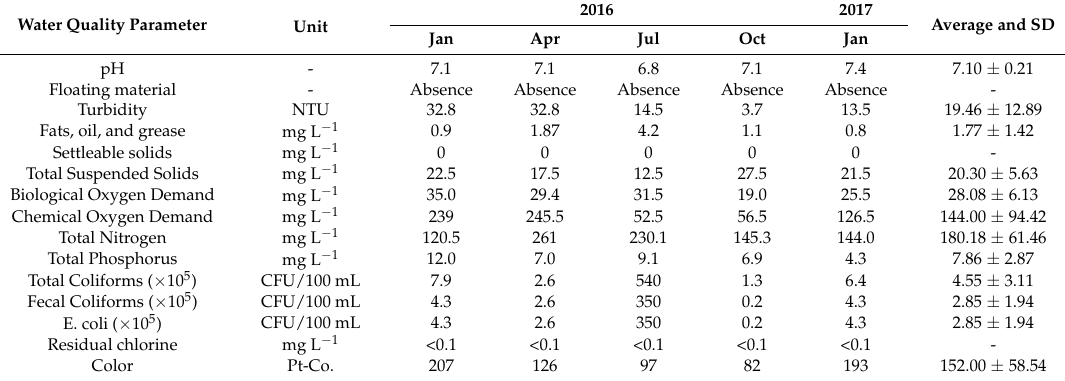
Table 4. Water quality parameters at the outlet of the up-flow anaerobic filter (UAF) (SD = standard